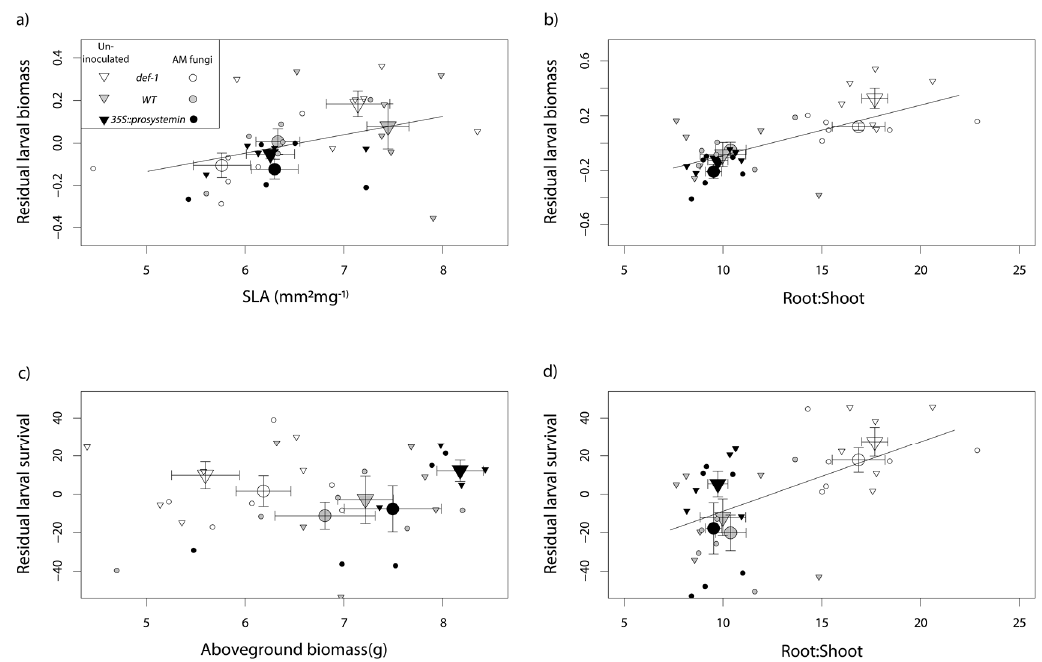
Figure 6. Effect of plant growth and defensive traits on S. littoralis caterpillar performance. Seven plant traits were included in the analysis but only the significant predictors following stepAIC selection are illustrated: ( a ) SLA and ( b ) root:shoot to explain larval biomass and ( c ) aboveground biomass and ( d ) root:shoot to explain larval survival. Residual larval biomass and larval survival refers to the statistical model with the other factor in the analysis. Larger points represent mean ± SE. The plants have different genotype shown with different colors: JA expression deficient plants (def-1) in white, wild-tape plants ( WT ) in grey, and JA over-accumulating plants (35S::prosystemin) in black. Different geometrical figures represent AM-fungal treatment: triangles represent un-inoculated plants and circles AM-inoculated plants ( n = 36).